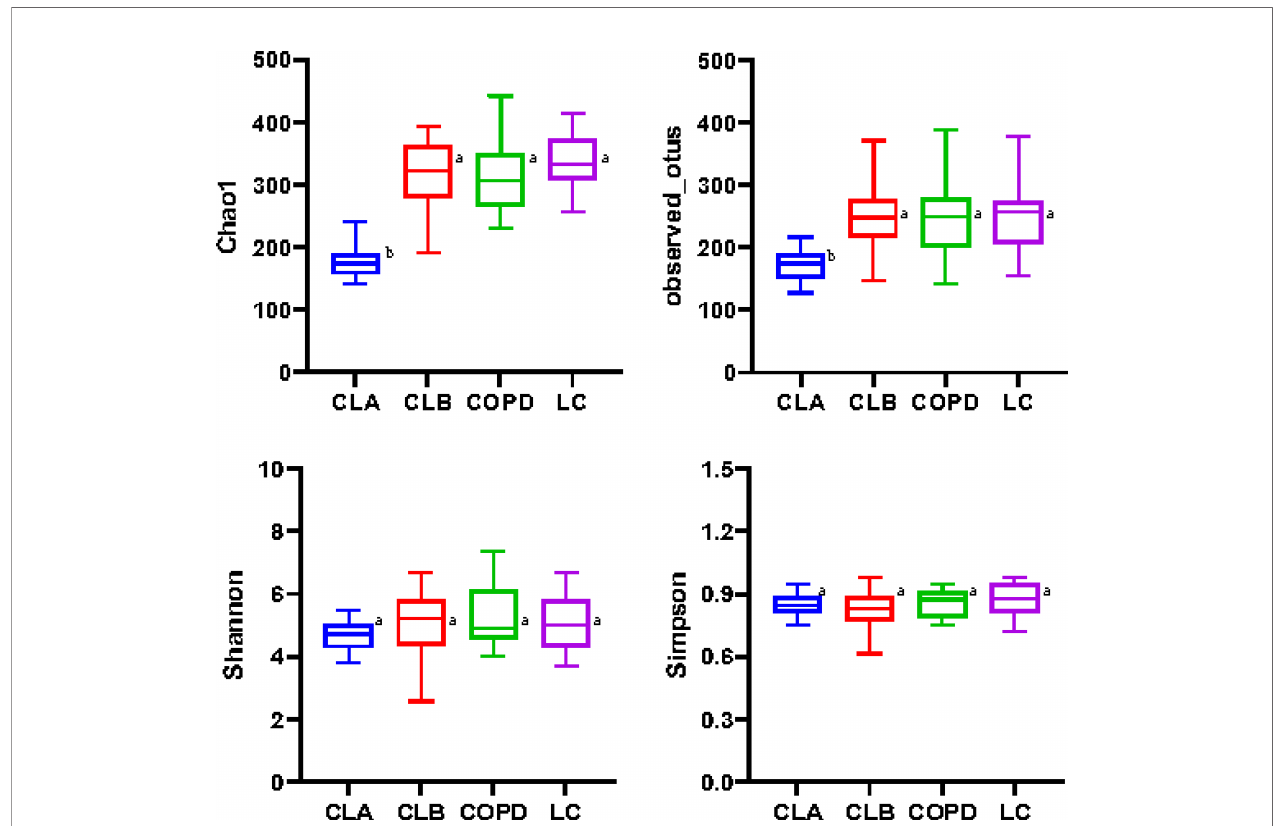
FIGURE 2 | Alpha diversities of the induced sputum samples from different groups. Different indices (Chao1, Observed_otus, Shannon, and Simpson) were used to estimate the number of microbiota in samples. Data shown are the median ± quartile. Different letters indicate statistically signi fi cant differences. p <